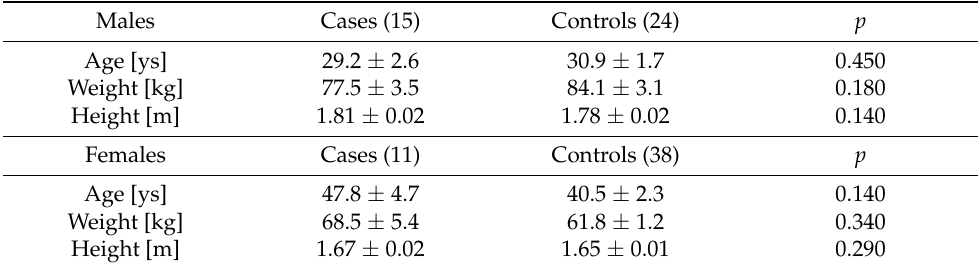
Table 1. Characteristics of cases and controls.